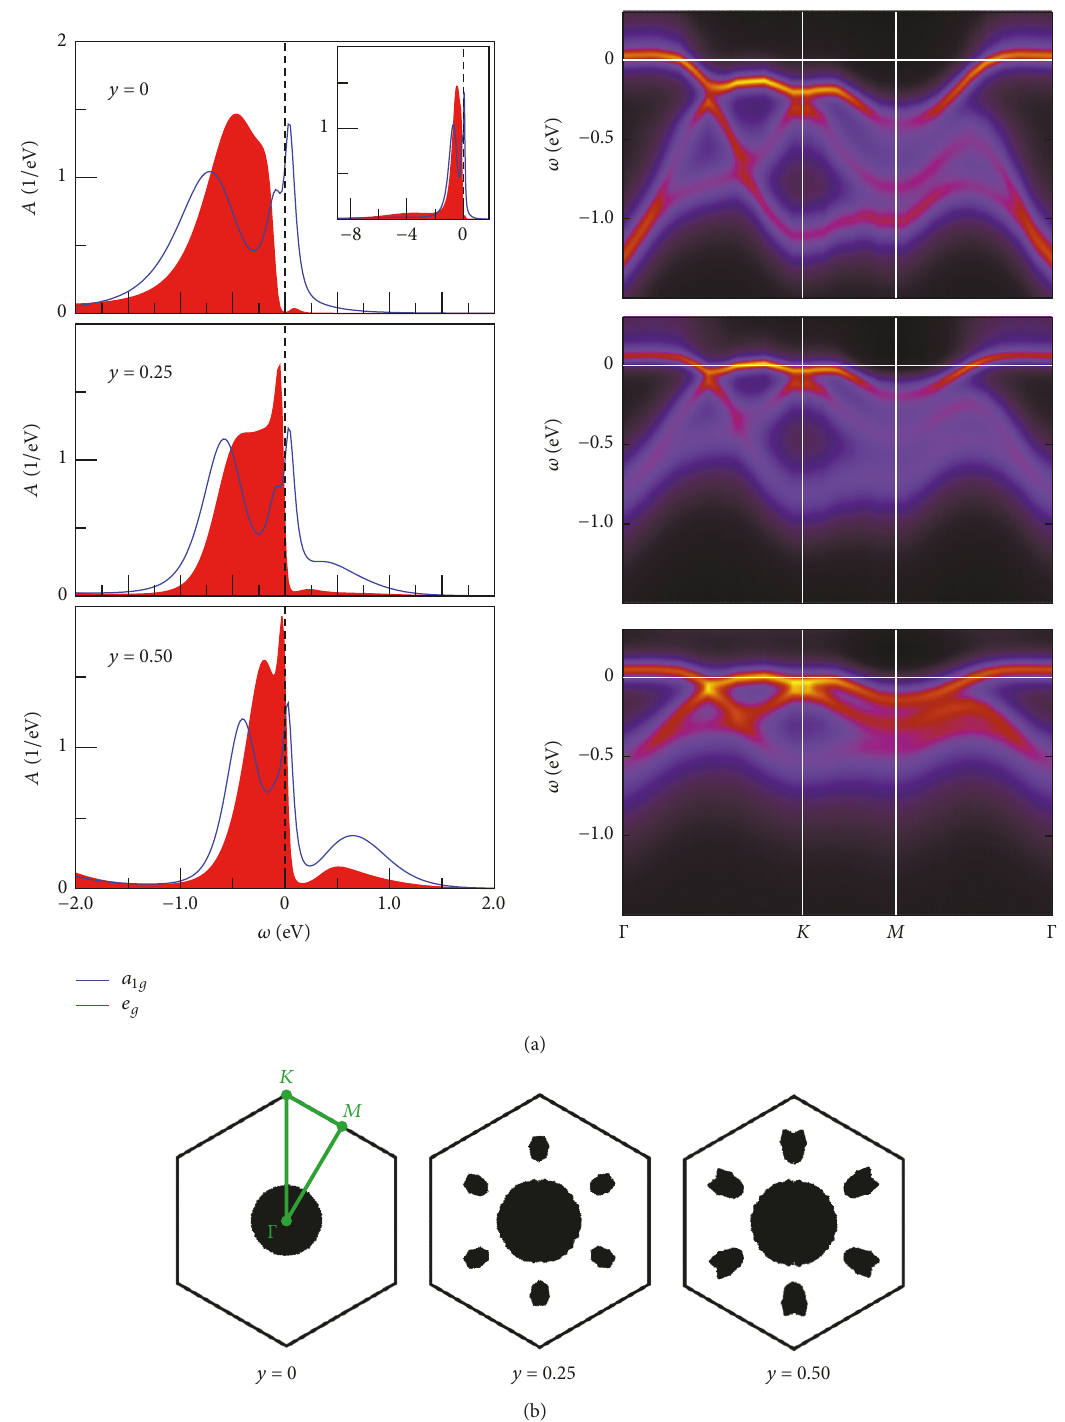
Figure 3: (Color online) DFT+DMFT electronic structure for Na 0.7 Co 1−𝑦 Fe 𝑦 O 2 . (a) Spectral function for different 𝑦 . Left: 𝑘 -integrated 𝐴 = ∑ 𝐴( k , 𝜔) and right: 𝑘 -resolved along high-symmetry lines in the Brillouin zone. (b) 𝑦 -dependent k